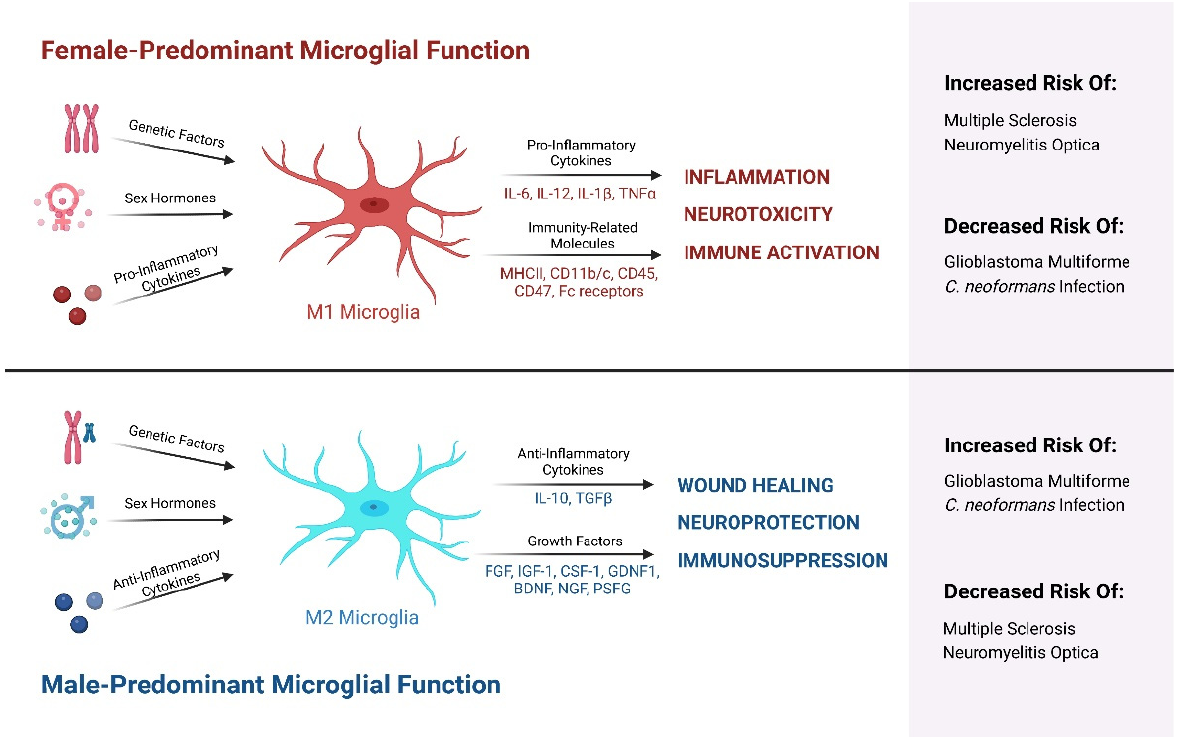
Figure 2. Sexually dimorphic pathological activation of microglia. Genetic and environmental factors such as sex hormones and cytokines shift microglia to a female-predominant M1 and male-predominant M2 phenotype. The intrinsic functions of these sexually dimorphic cells then support the development or resolution of a variety of CNS pathologies. (Created with Biorender.com on 6 February 2023) Abbreviations: IL-6, interleukin-6; IL-12, interleukin-12; IL-1 β , interleukin-1 beta; TNF α , tumor necrosis factor alpha, MHCII, major histocompatibility complex II; IL-10, interleukin- 10; TGF β , transforming growth factor beta; FGF, fibroblast growth factor; IGF-1, insulin-like growth factor-1; GDNF1, glial-derived neurotrophic factor 1; BDNF, brain derived neurotrophic factor; NGF, nerve growth factor; PSFG, pro-survival factor granulin.